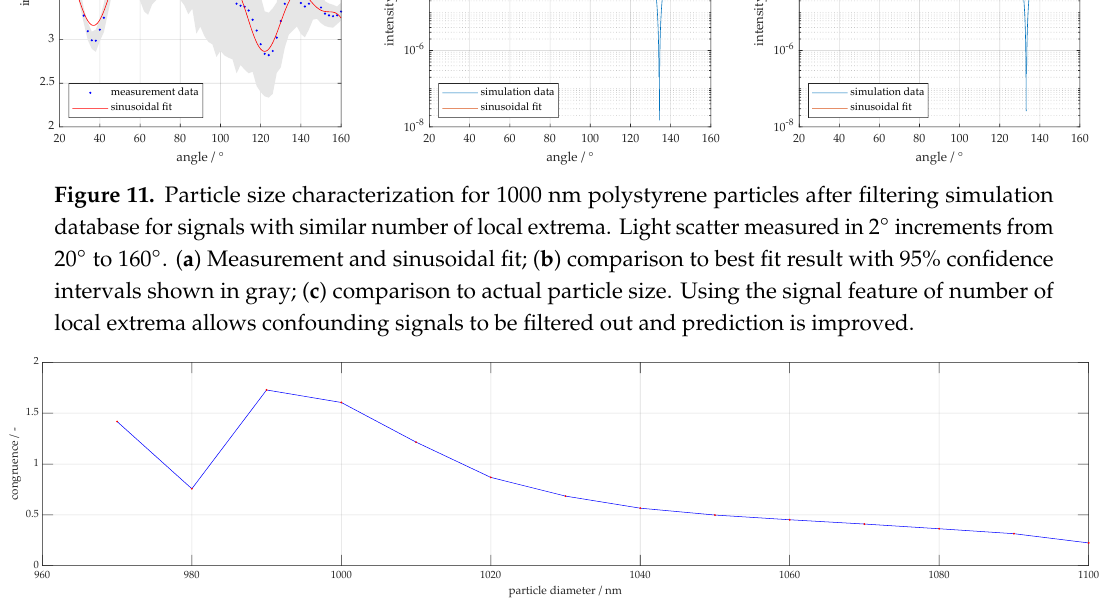
Figure 12. Overall congruence of 1000 nm measurement to simulation database after filtering for signals with similar number of local